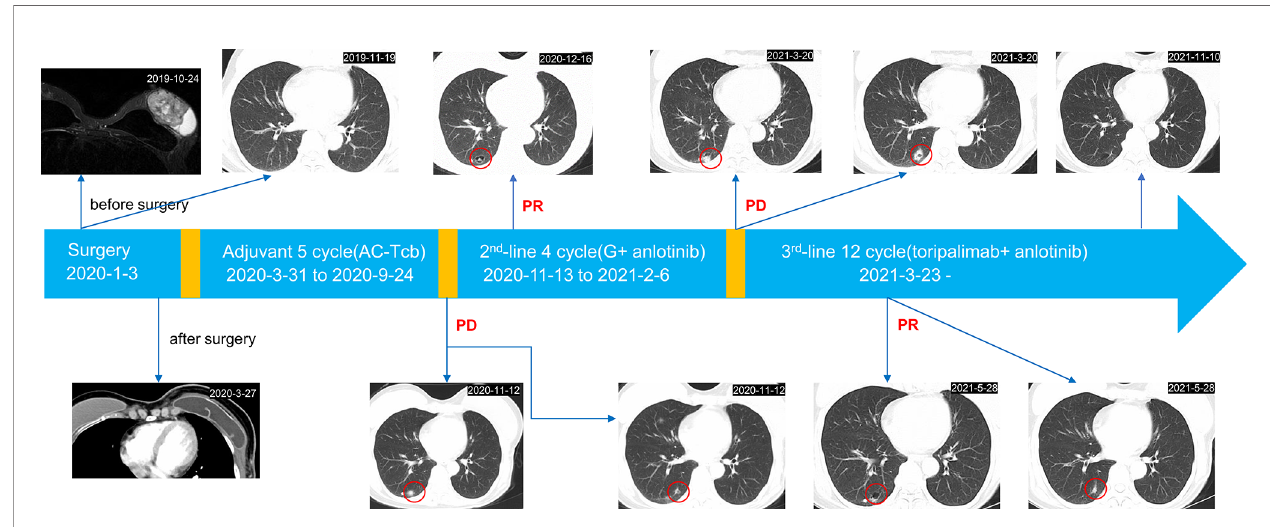
FIGURE 1 | Complete treatment process of the patient since